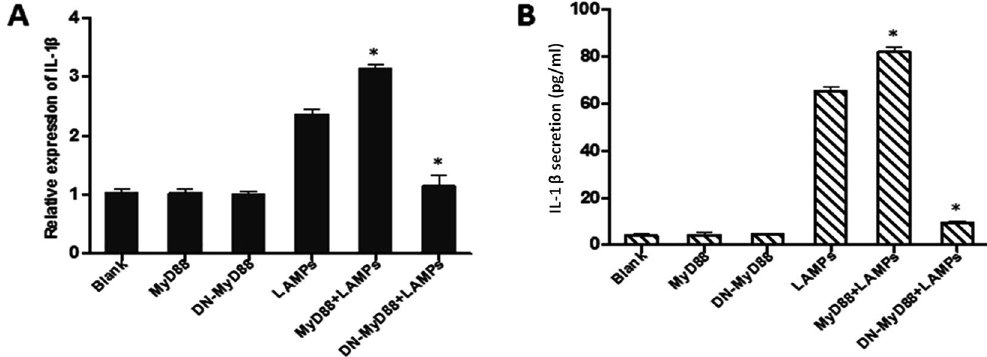
Figure 5. MyD88 is required for LAMP-induced IL-1 β expression. EBL cells were transiently transfected with 0.2 μ g/mL pHA-MyD88 or 0.2 μ g/mL pHA-DN-MyD88. After 24 h, the cells were stimulated with or without 1.0 μ g/mL LAMPs. After 6 h, cells and supernatants were respectively harvested and analyzed by ( A ) real-time PCR and ( B ) ELISA. Data are presented as the mean and standard deviation of three assays. * p < 0.05 compared with the LAMP-stimulated group.